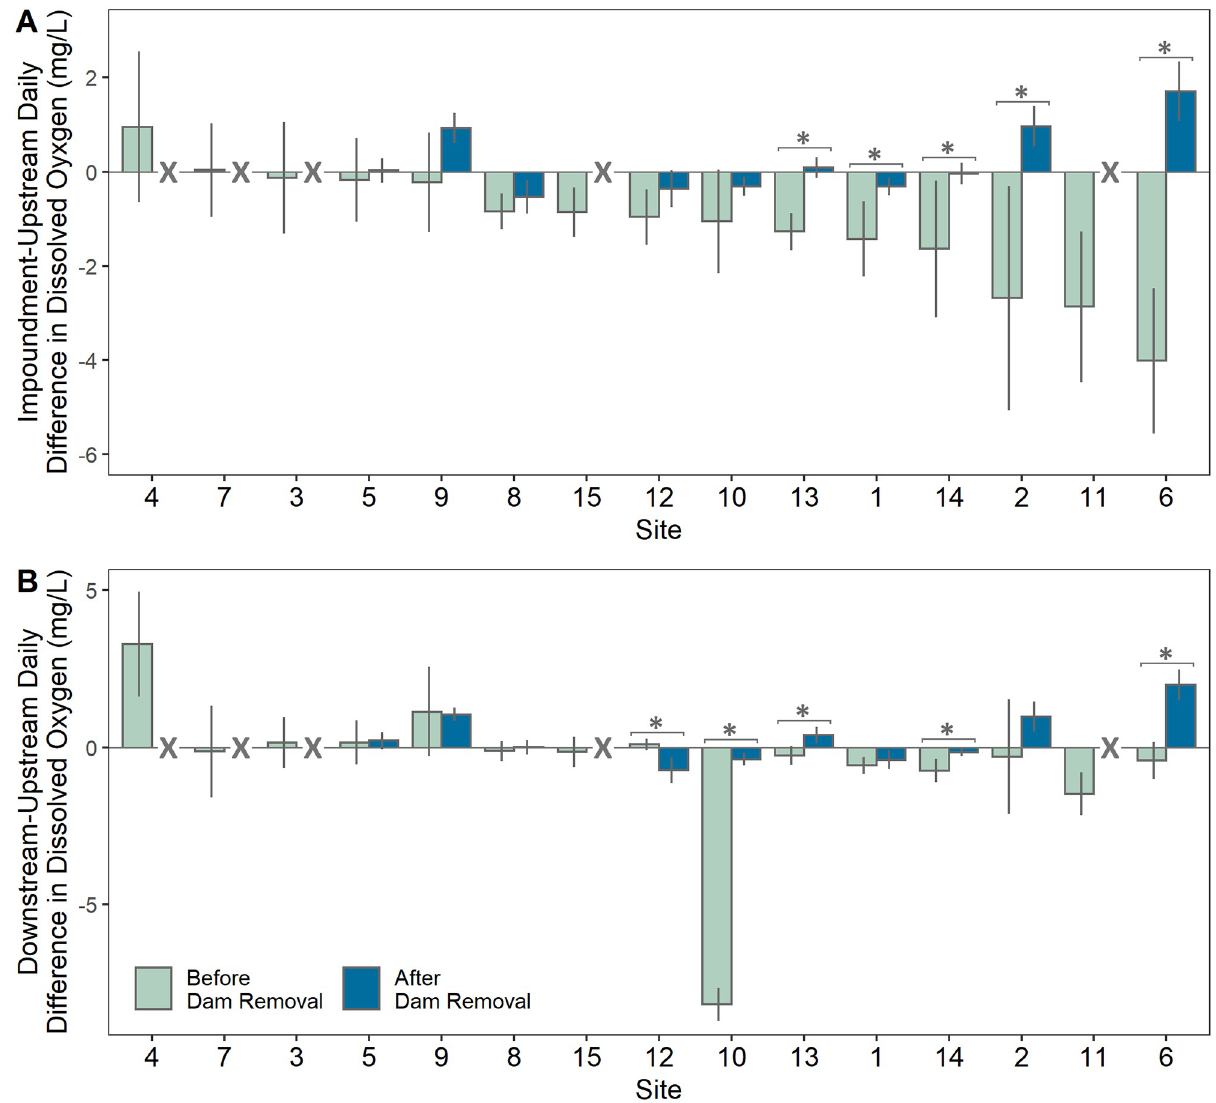
Fig 2. Dissolved oxygen (DO) effects before and after dam removal. (A) Variation in impoundment effect (mean daily impoundment minus upstream DO) by site before and after dam removal. (B) Variation in downstream effect (mean daily downstream minus upstream DO). Error bars represent one standard deviation about the mean. The horizontal line at zero indicates no difference between impoundment or downstream DO and the upstream reference. Significant differences ( α = 0.05) between DO effects before and after dam removal are annotated with an asterisk ( � ) and sites where the dam was not removed during this study are annotated with an X. Sites are ordered from lowest to highest pre-removal impoundment